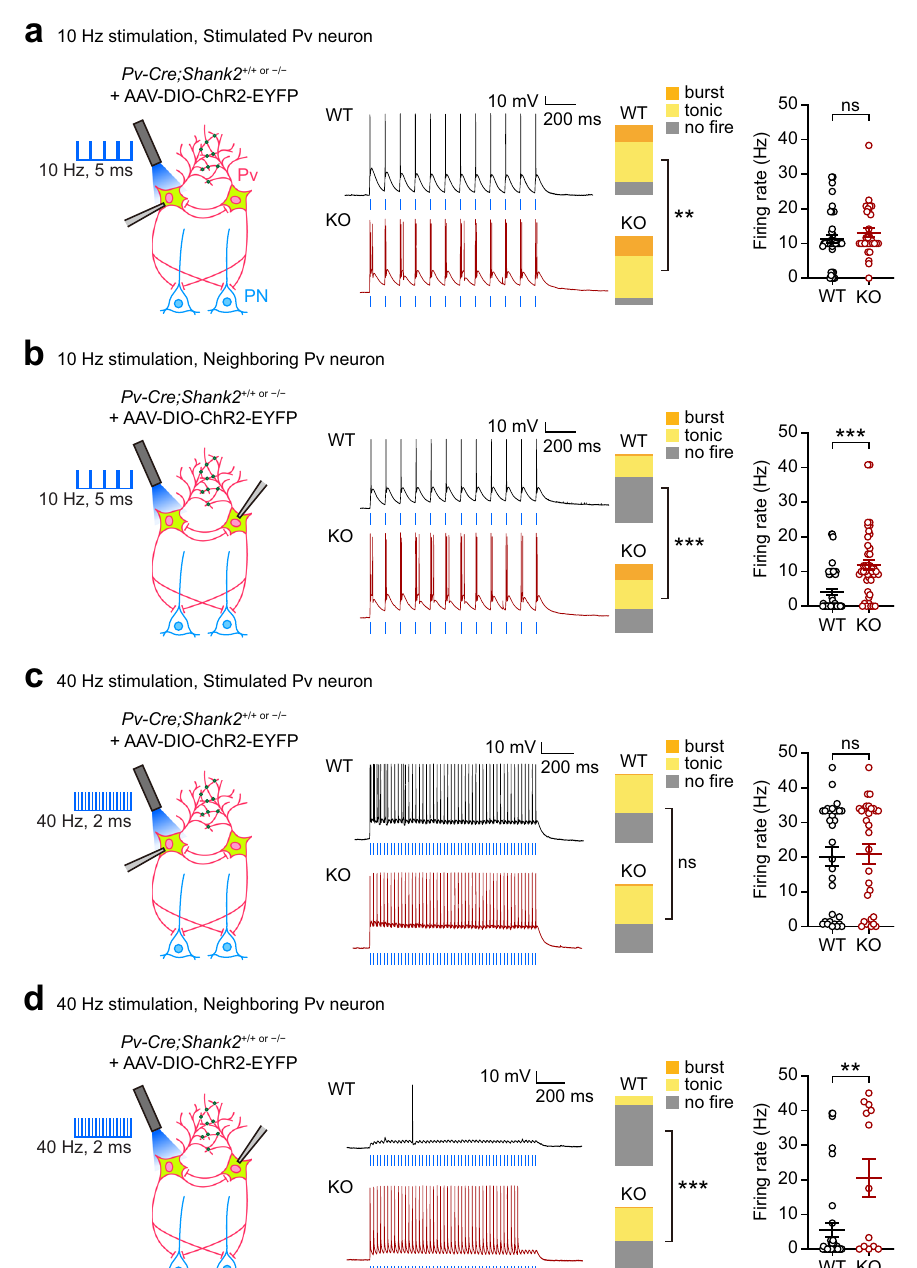
Fig. 5 Burst fi ring in Shank2 – / – Pv neurons strongly induced by 10-Hz, but not 40-Hz, stimulation. a Increased burst fi rings in single Pv neurons focally light-stimulated in the cell body in the Shank2 – / – mPFC (prelimbic, layer 2/3), as shown by proportions of neurons with speci fi c fi ring patterns (no- fi re, tonic- fi re, burst- fi re). Note that the mean- fi ring rate shows only an increasing tendency. A single Pv neuron in acute slices from Pv-Cre; Shank2 – / – or Pv- Cre;WT (control) mice (>12 weeks) infected in the mPFC with AAV-DIO-ChR2-EYFP (3 weeks) was stimulated by blue light (473 nm, 10 Hz, 5 ms, 12 epochs) ( n = 42 neurons from 9 mice [WT], 31/12 [KO], ** p < 0.01, ns, not signi fi cant, Chi-square test [proportion], two-tailed Mann – Whitney test [ fi ring rate]; p = 0.0028 [proportion], p = 0.2561 [ fi ring rate]). b Increased burst fi rings in Pv neurons neighboring a light-stimulated single Pv neuron in the Shank2 – / – mPFC, as shown by proportions of fi ring patterns and mean- fi ring rates ( n = 47/10 [WT], 42/15 [KO], *** p < 0.001, Chi-square test [proportion], two-tailed Mann – Whitney test [ fi ring rate]; p < 0.0001 [proportion], p < 0.0001 [ fi ring rate]). c , d Limited burst fi rings in light-stimulated and neighboring Pv neurons by 40 Hz stimulation in the Shank2 – / – mPFC ( n = 32/8 [WT], 30/10 [KO] for light-stimulated Pv neurons, 37/9 [WT], 17/9 [KO] for neighboring Pv neurons, ** p < 0.01, *** p < 0.001, ns, not signi fi cant, Chi-square test [proportion], two-tailed Mann – Whitney test [ fi ring rate]; p = 0.7524 [proportion-c], p = 0.671 [ fi ring rate-c], p < 0.0001 [proportion-d], p = 0.0067 [ fi ring rate-d]). See Source data for raw data values and Supplementary Table 1 for statistical